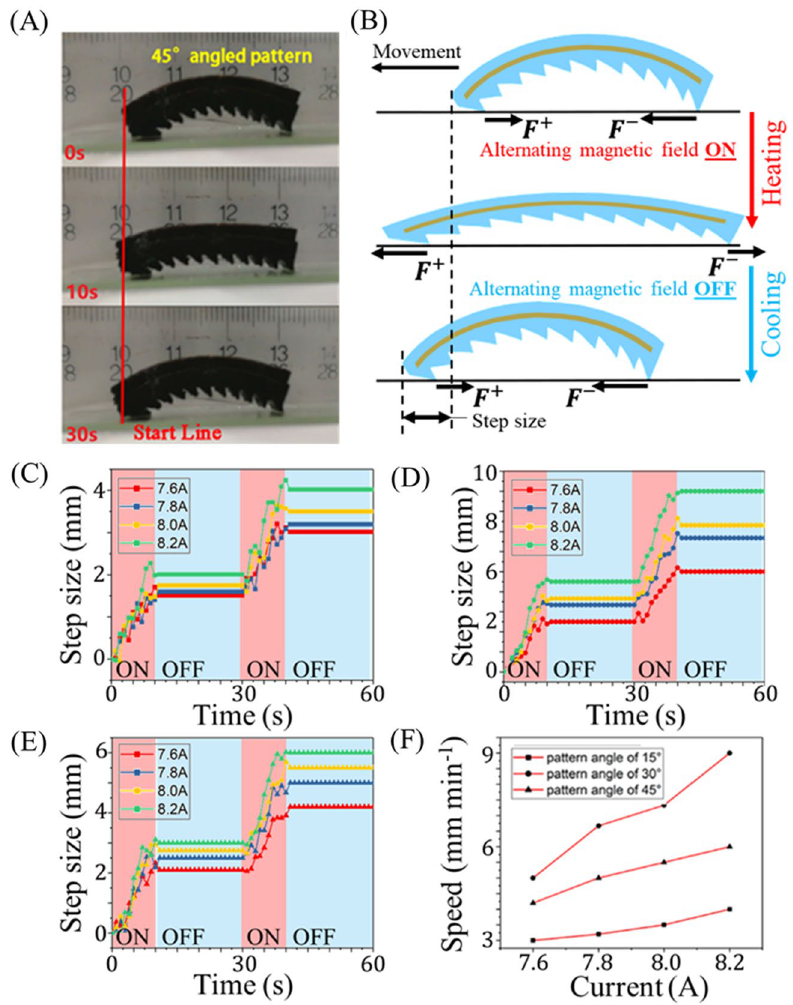
Figure 6. Motion principle and kinematic behavior analysis of mag-bot. ( A ) Snapshots of a mag-bot undergoing one thermal load cycle display movement leftwards. The top snapshot is presented at the beginning of heating (0 s); the middle snapshot is shown at the end of heating and beginning of cooling (10 s); and the bottom snapshot depicts the end of cooling (30 s). ( B ) A schematic illustrates the direction of frictional forces on the forefoot ( F + ) and hindfoot ( F − ) as well as the emergent step size after one loading cycle (not to scale). ( C–E ) Step sizes are plotted with respect to time for mag-bots with (C) 15°, (D) 30°, and (E) 45° pattern angles for two cycles of thermal loading, over a range of magnetically induced currents ( I ∈ [ 7.6,8.2 ] A ). (F) Velocity is plotted with respect to induction current for mag-bots with pattern angles of 15° (squares), 30° (circles), and 45°